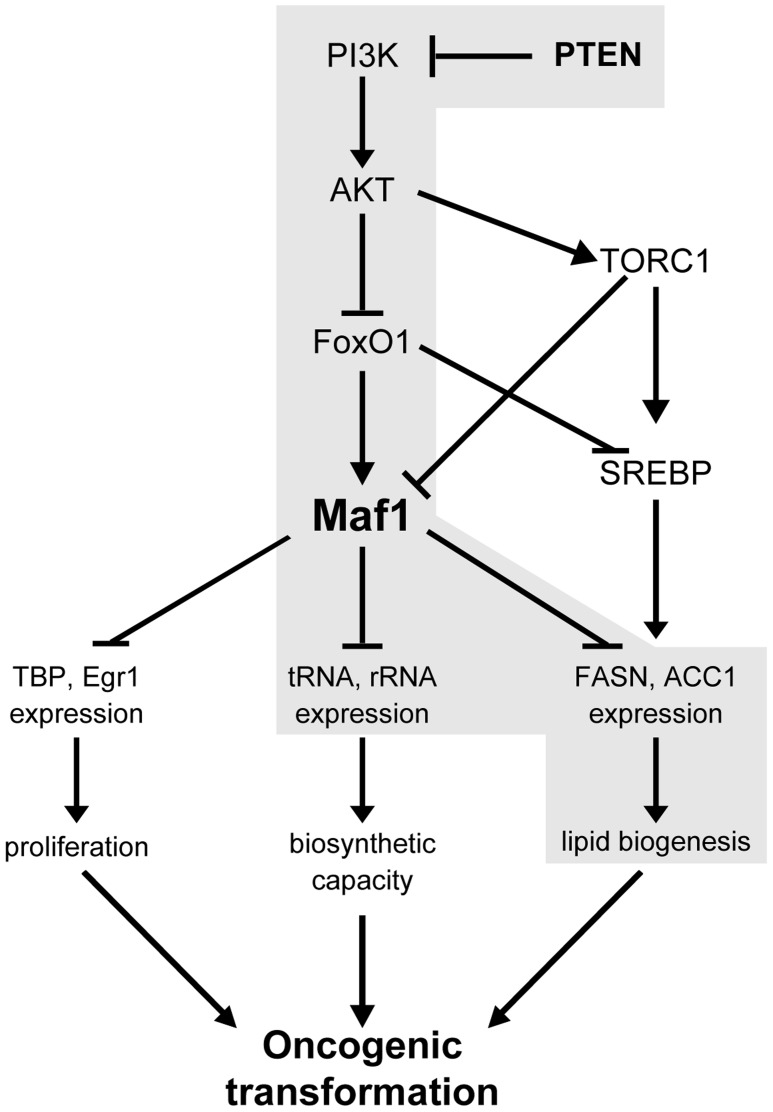
Maf1 is a central coordinator of metabolic signals.Shown is a model depicting the proposed mechanism for the regulation of Maf1 expression by PTEN and the consequences of altered Maf1 expression on gene expression pathways that regulate the oncogenic potential of cells. New findings are highlighted in grey.